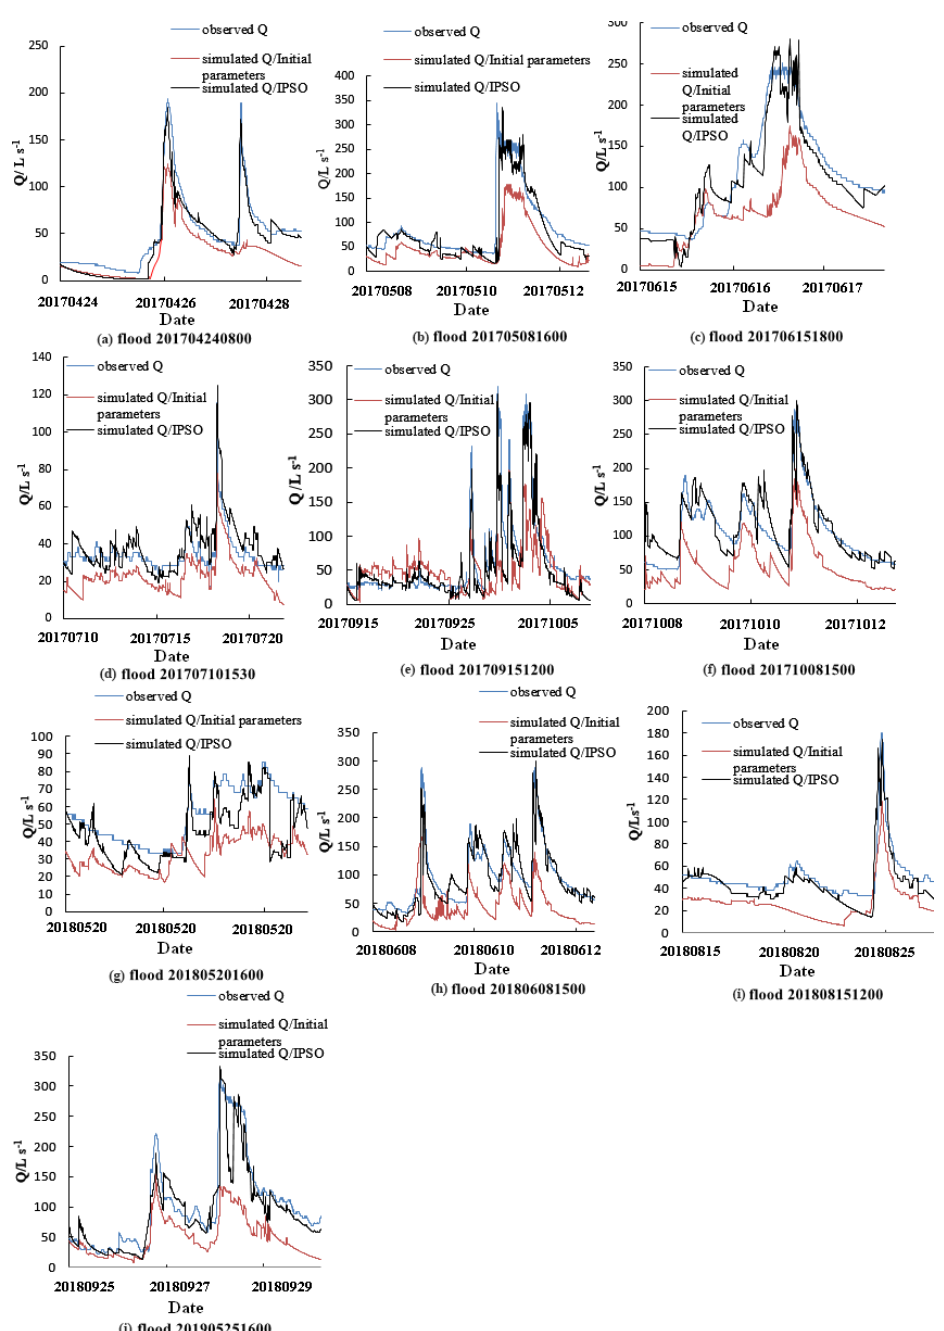
Figure 7. Flood simulation effects based on the initial and optimized